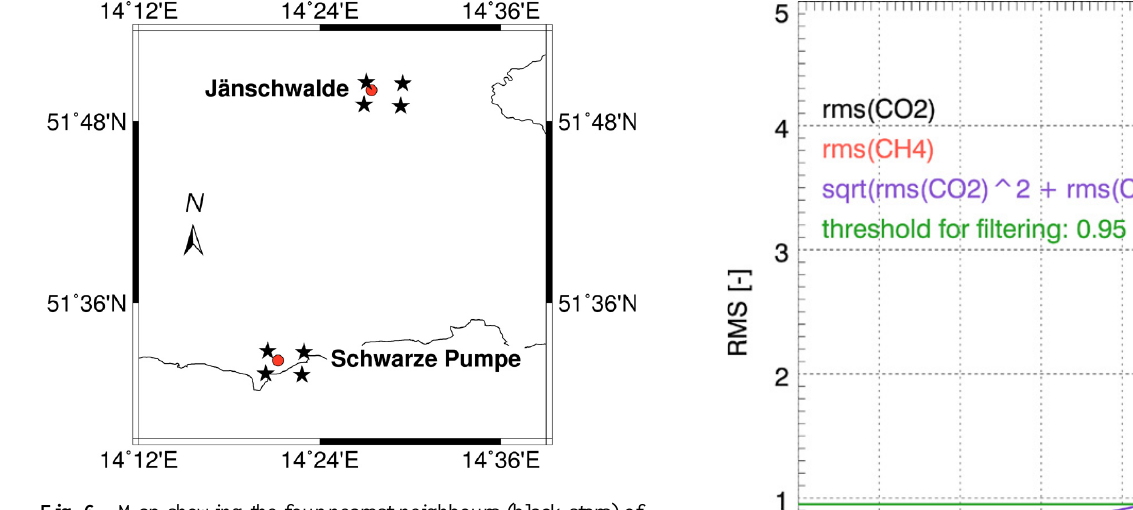
Fig. 6. Map showing the four nearest neighbours (black stars) of the power plants J¨anschwalde and Schwarze Pumpe (red circle). Each of the power plants has a South-West, South-East, North-West and a North-East nearest neighbour according to the COSMO-DE data grid. The distance between both power plants is about 35km. Note that the map is not equidistant in North-South and East-West direction.